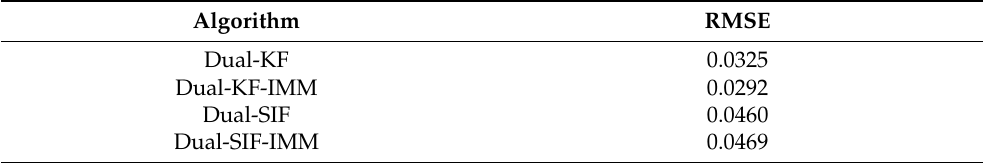
Table 4. B036 RMSE: Battery Capacity Estimation.